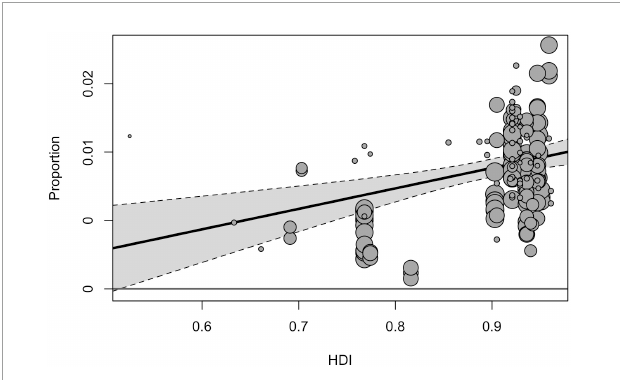
FIGURE3 The meta-regression analysis of the effect of the HDI on the pooled prevalence of